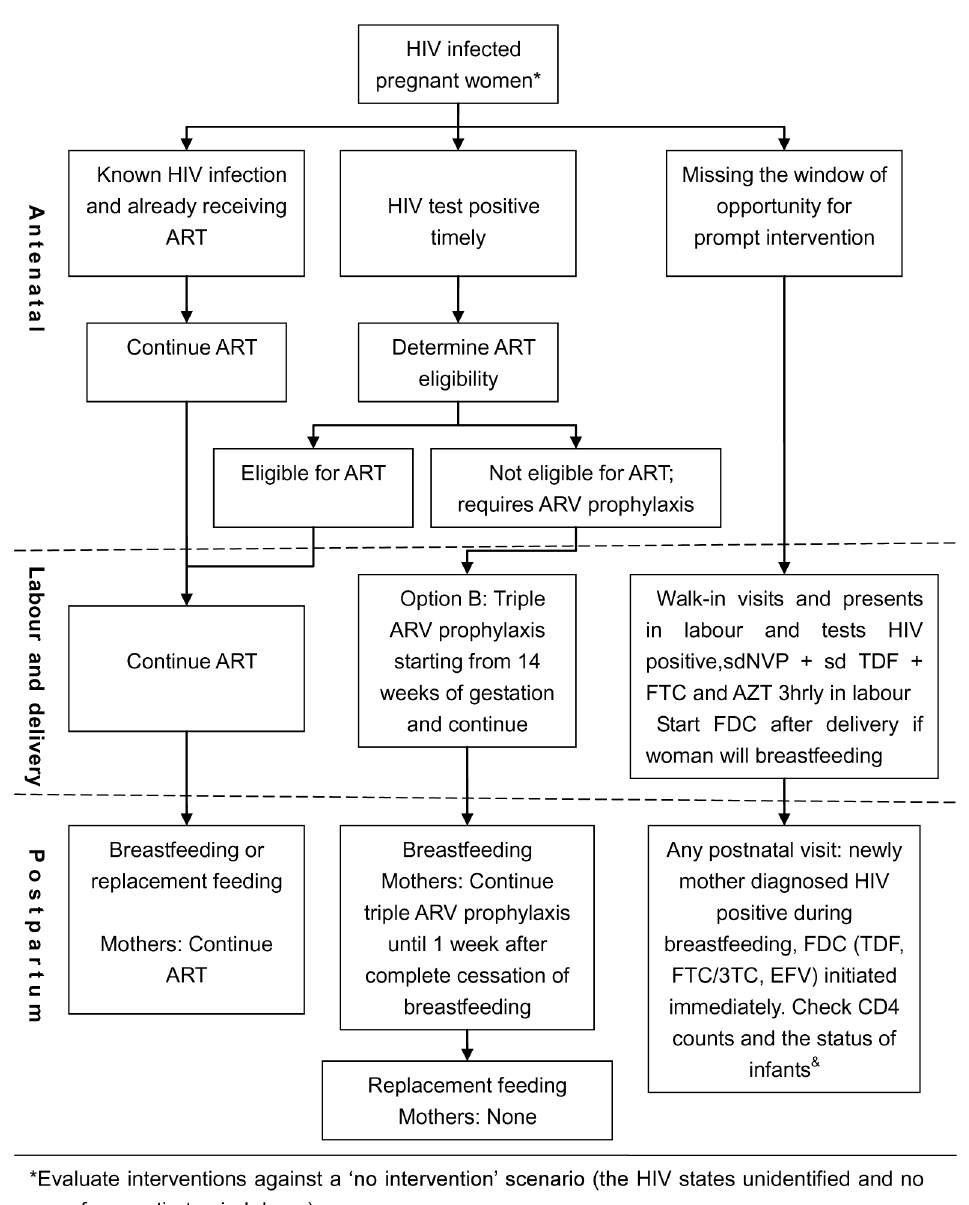
Figure 1. Decision analytic model schematic. & Irrespective of mode of feeding patterns, infants accepted NVP promptly and daily for 6 weeks. ART, antiretroviral therapy; ARV, antiretroviral prophylaxis; sdNVP, single dose nevirapine; sdTDF, single dose Tenofovir; FTC,emtricitabine; AZT, Zidovudine; FDC, fixed dose combination,(TDF, FTC/3TC, EFV); 3TC,Lamivudine; EFV, Efavirenz.